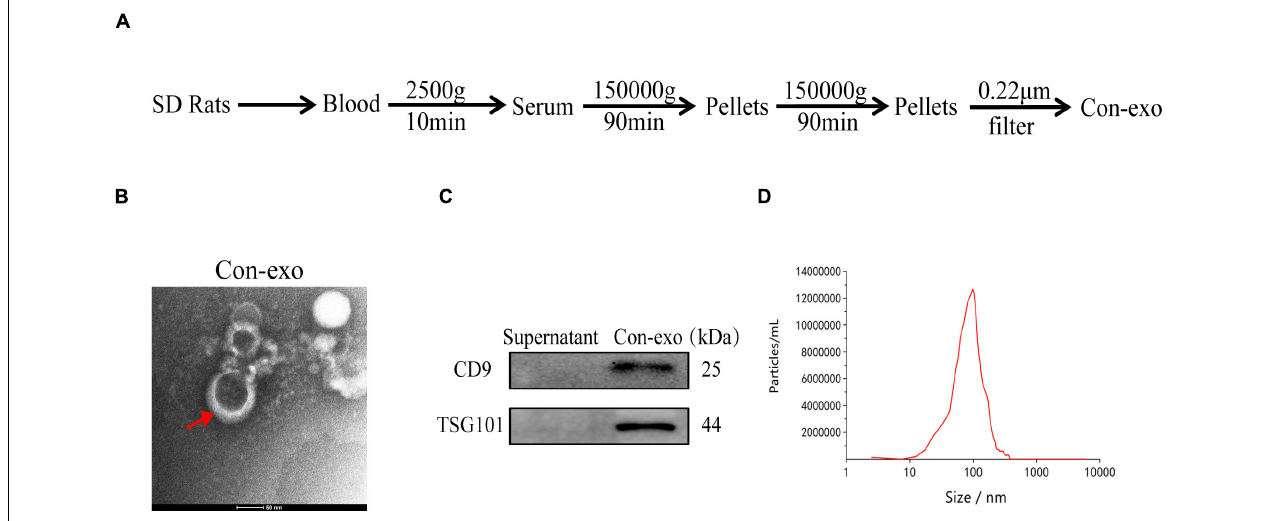
Frontiers in Cellular Neuroscience |